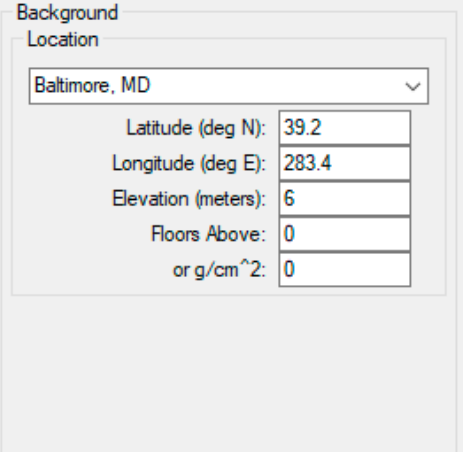
simulation used in GADRAS can be seen in Figure 5.